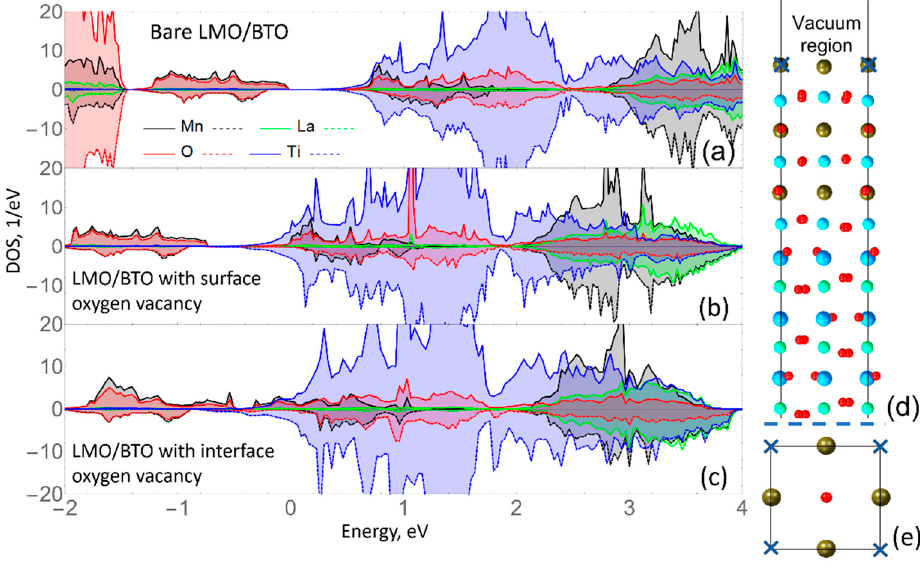
Figure 6. ( a ) Spin-polarized DOS spectra for bare BTO/LMO and ( b ) with oxygen vacancy at the surface and ( c ) at the interface. Side ( d ) and ( e ) top view onto the LMO/BTO supercell. The upper half is presented here without a full vacuum region.